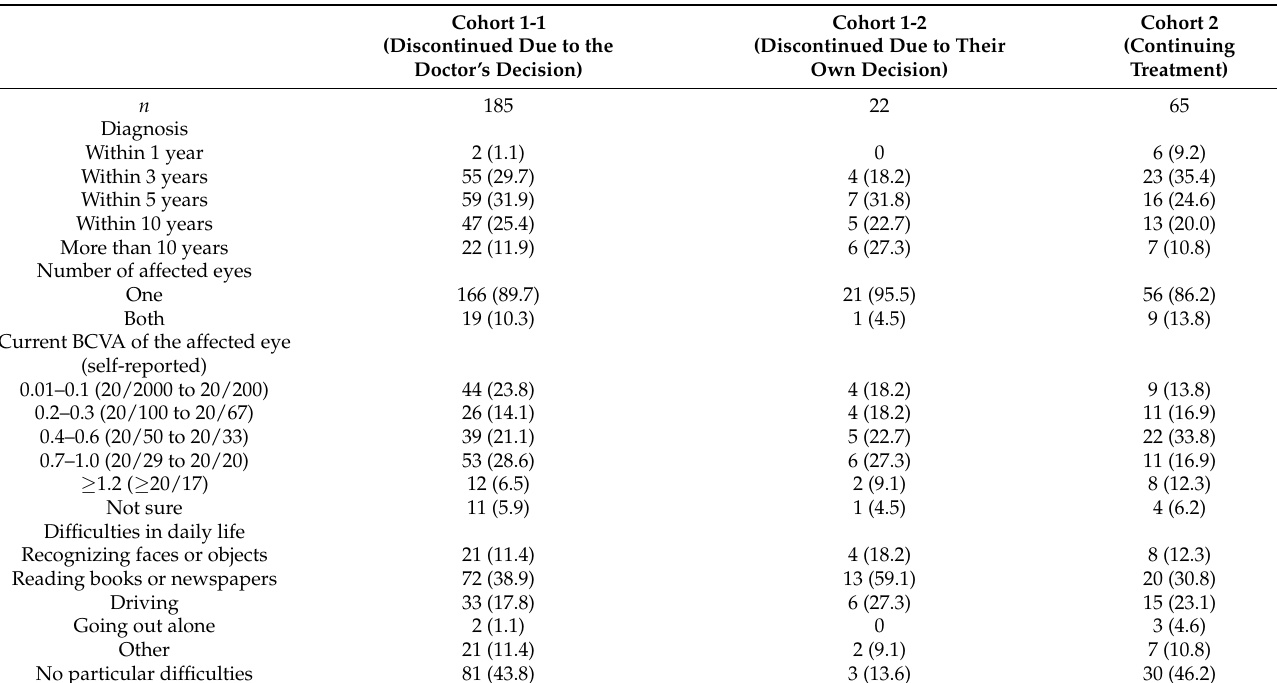
Table 2. Disease onset and visual problems.